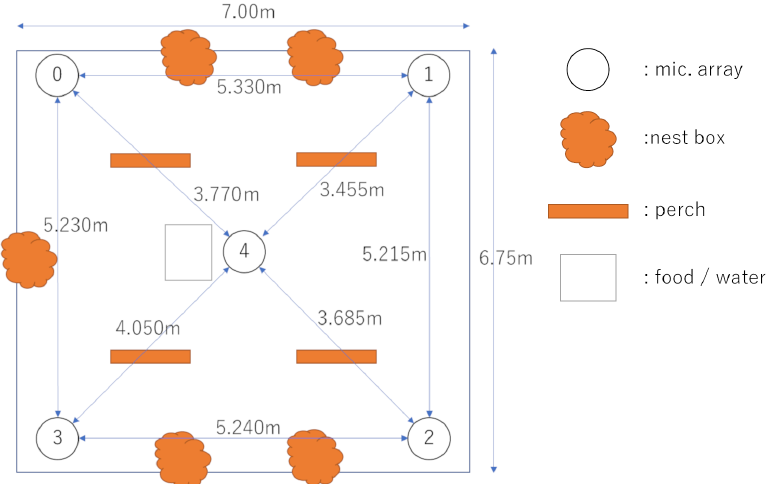
Figure 2. Arrangement of the experimental